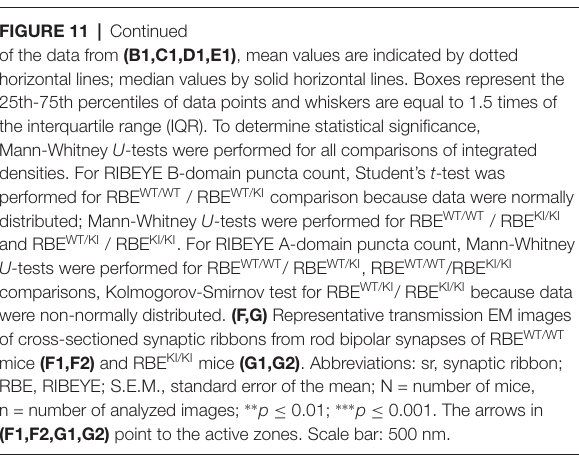
FIGURE 11 | Continued of the data from (B1,C1,D1,E1) , mean values are indicated by dotted horizontal lines; median values by solid horizontal lines. Boxes represent the 25th-75th percentiles of data points and whiskers are equal to 1.5 times of the interquartile range (IQR). To determine statistical significance, Mann-Whitney U -tests were performed for all comparisons of integrated densities. For RIBEYE B-domain puncta count, Student’s t -test was performed for RBE WT/WT / RBE WT/KI comparison because data were normally distributed; Mann-Whitney U -tests were performed for RBE WT/WT / RBE KI/KI and RBE WT/KI / RBE KI/KI . For RIBEYE A-domain puncta count, Mann-Whitney U -tests were performed for RBE WT/WT / RBE WT/KI , RBE WT/WT /RBE KI/KI comparisons, Kolmogorov-Smirnov test for RBE WT/KI / RBE KI/KI because data were non-normally distributed. (F,G) Representative transmission EM images of cross-sectioned synaptic ribbons from rod bipolar synapses of RBE WT/WT mice (F1,F2) and RBE KI/KI mice (G1,G2) . Abbreviations: sr, synaptic ribbon; RBE, RIBEYE; S.E.M., standard error of the mean; N = number of